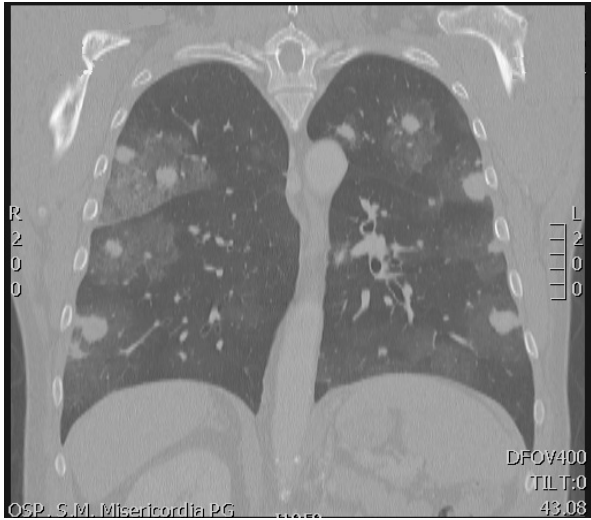
Figure 5: CORONAL CT SCAN showing several nodular opacities of the lungs with ground glass opacity and tree-in-bud signs